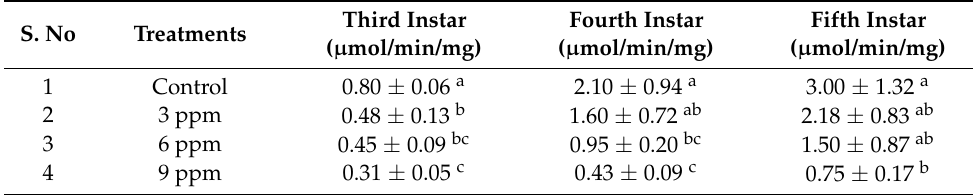
Values followed by different alphabets show significant differences ( p < 0.05) between control and